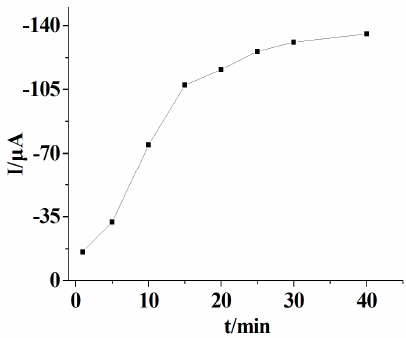
Figure 3. Plots of peak current vs. accumulation time.